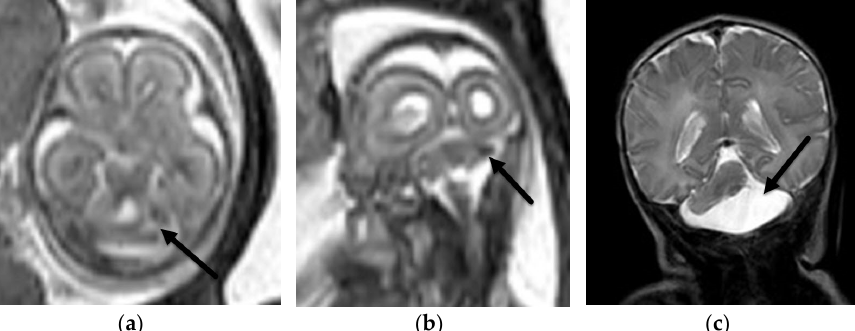
Figure 9. Unilateral cerebellar injury. Axial ( a ) and coronal ( b ) T2-SSFSE images from fetal MRI hypointense blood products (arrows). ( c ) Coronal T2-FSE image from postnatal MRI at day of life 1 in the same patient demonstrates absence of the left cerebellar hemisphere (arrow) compatible with evolution of prenatally diagnosed cerebellar